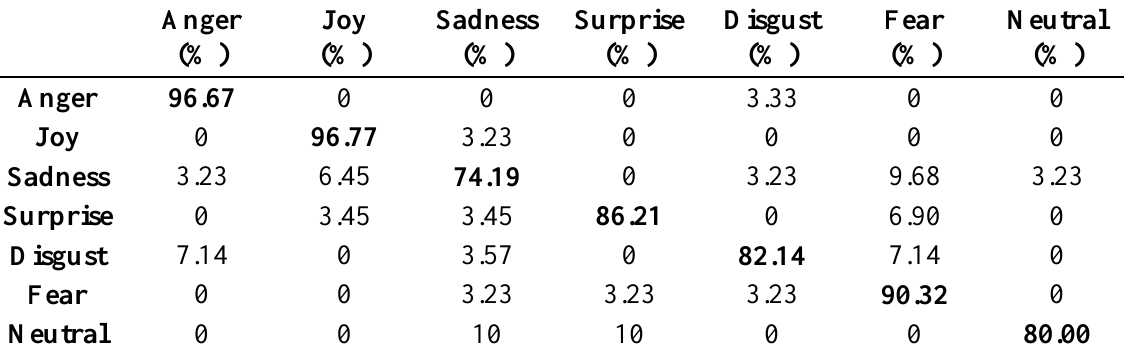
Table 5. Confusion matrix of classification results of NNLS when performs best with the LBP